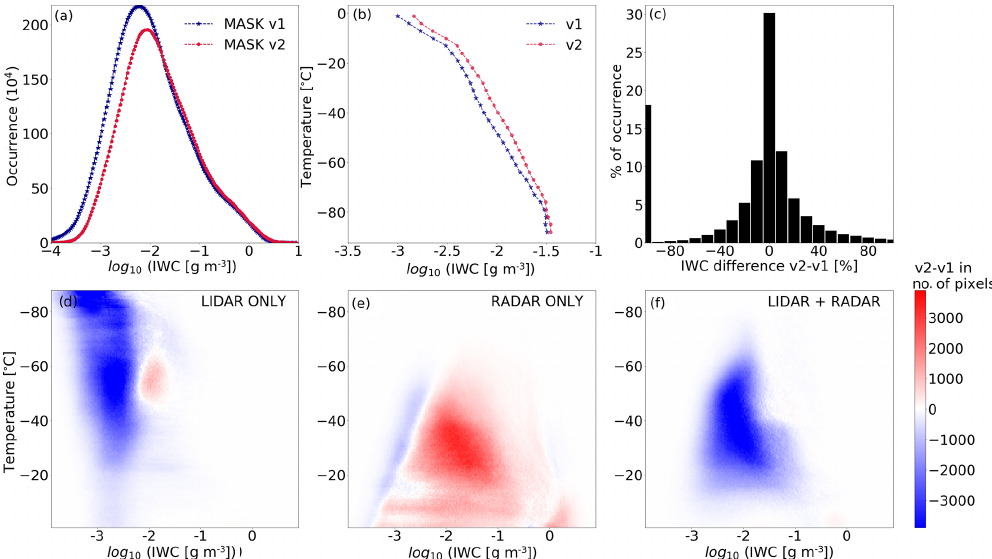
Figure 5. Comparison of DARDAR-MASK v1 and DARDAR-MASK v2 in terms of IWC retrieved using Varcloud ( V 2 ): histograms of log 10 ( IWC ) (a) with the old version of DARDAR-MASK in dashed line and the new version in solid line, the mean of the distribution of log 10 ( IWC ) as a function of temperature (b) for DARDAR-MASK v1.1.4 (dashed line) and DARDAR-MASK v2.1 (solid line), the − IWC v1 histogram of the relative difference IWC v2 between DARDAR-MASK v2 and DARDAR-MASK v1 (c) , and the difference between IWC v1 the two configurations in terms of number of pixels in each [ T − log 10 ( IWC ) ] bin for lidar-only pixels (d) , radar-only pixels (e) , and pixels combining the two instruments (f)